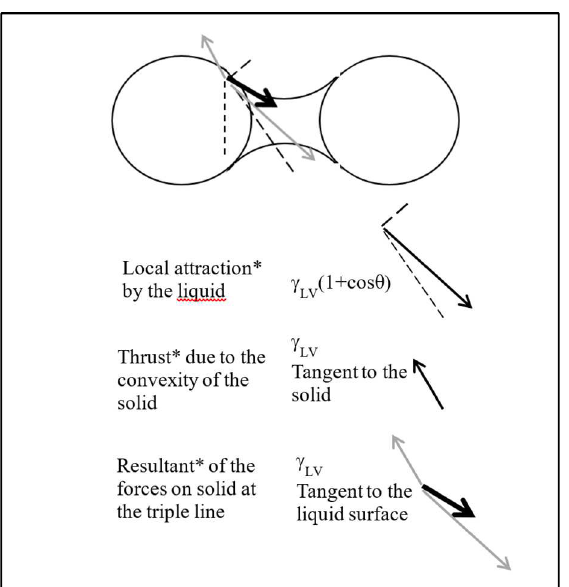
Fig . 8. Two types of forces act on a partly submerged body. The resultant* is tangent to the air/liquid interface. *All “forces” are by unit length of triple line.